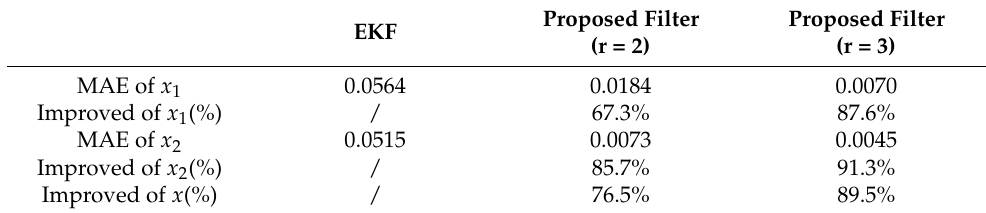
Table 3. Error comparison between the proposed filter and EKF in case